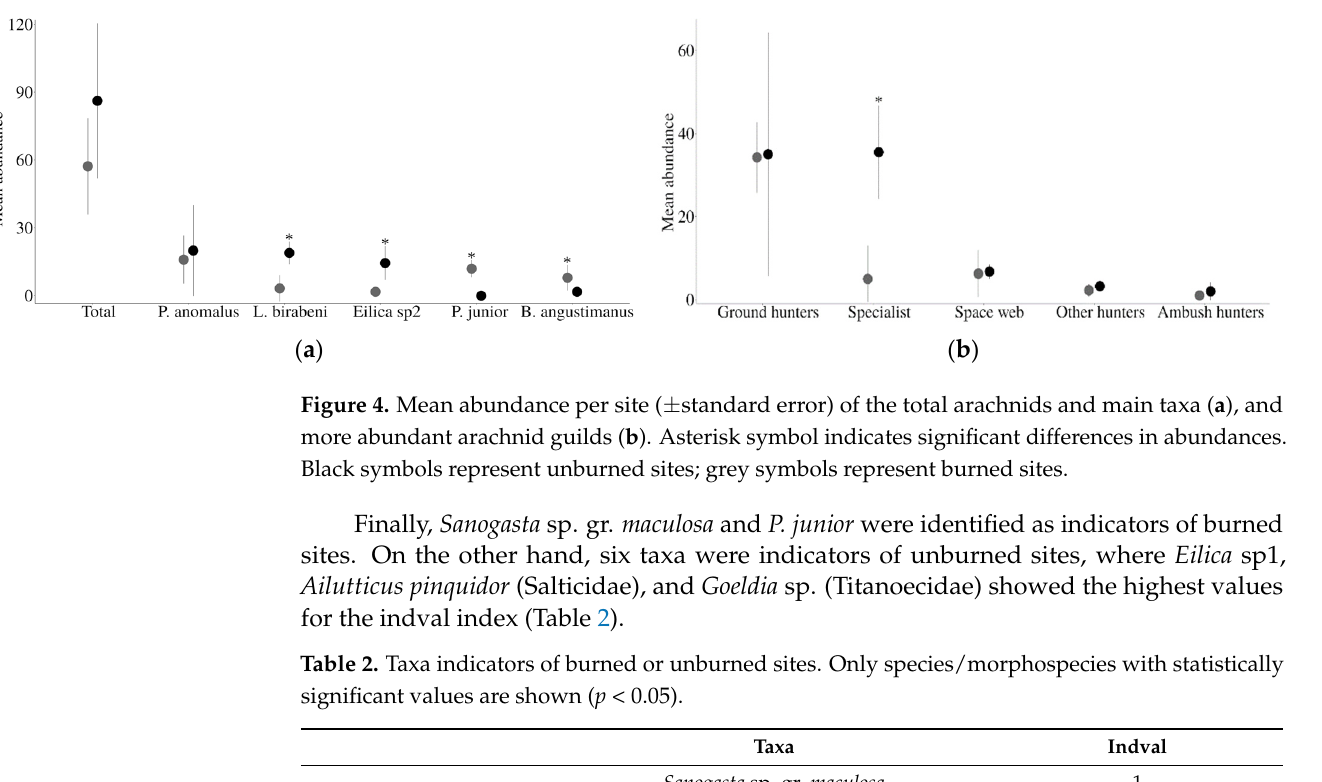
significant values are shown ( p <